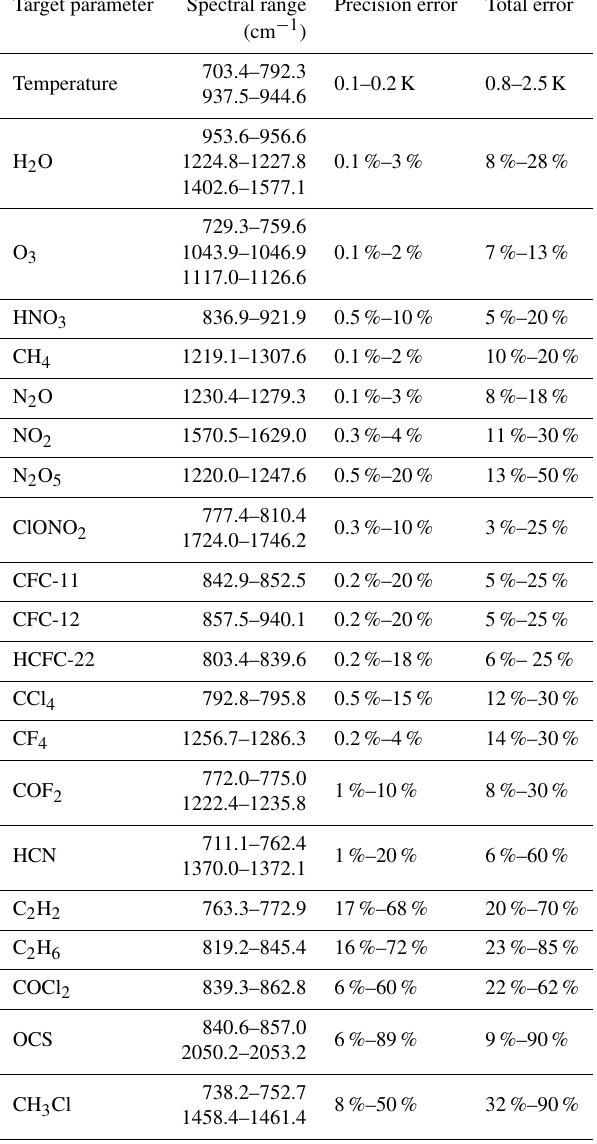
Table 1. Overview of MIPAS-E spectral windows used for the anal- ysis of atmospheric target parameters, together with typical preci- sion errors and total errors (OR mode, winter) in the altitude range of the compared MIPAS balloon